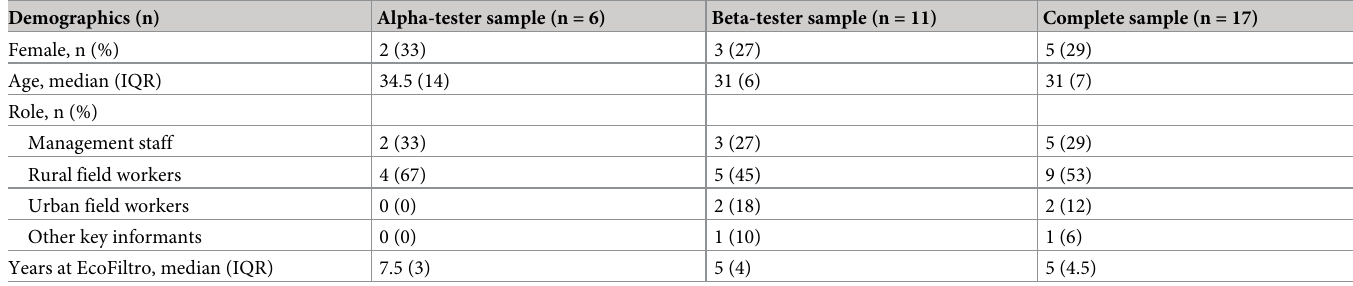
Table 1. Co-design participant